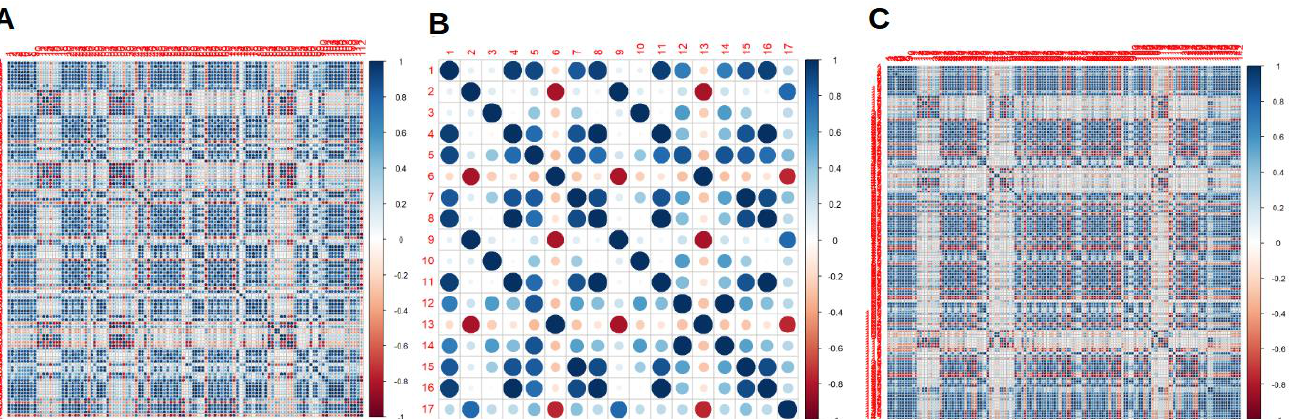
Table 2. Couples of RaF with best performances at logistic regression analysis for scanner 1, scanner 2 and both scanners together.